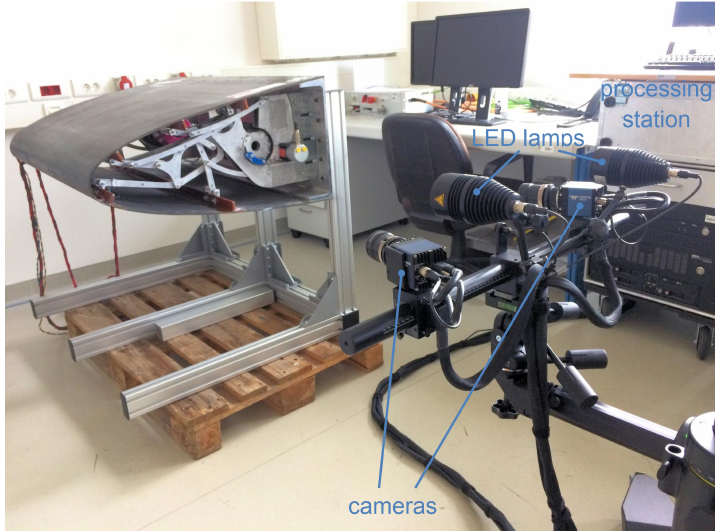
Figure 10. Photograph of the ARAMIS digital image correlation measurement setup for tracking kinematic and stringer